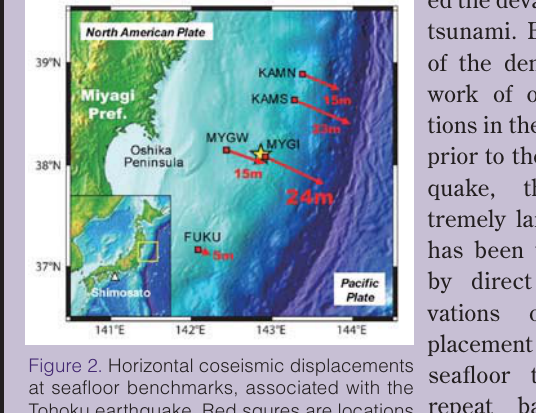
Figure 2. Horizontal coseismic displacements at seafloor benchmarks, associated with the Tohoku earthquake. Red squres are locations of GPS benchmarks and yellow star is the epicenter of the mainshock (Sato et al.,